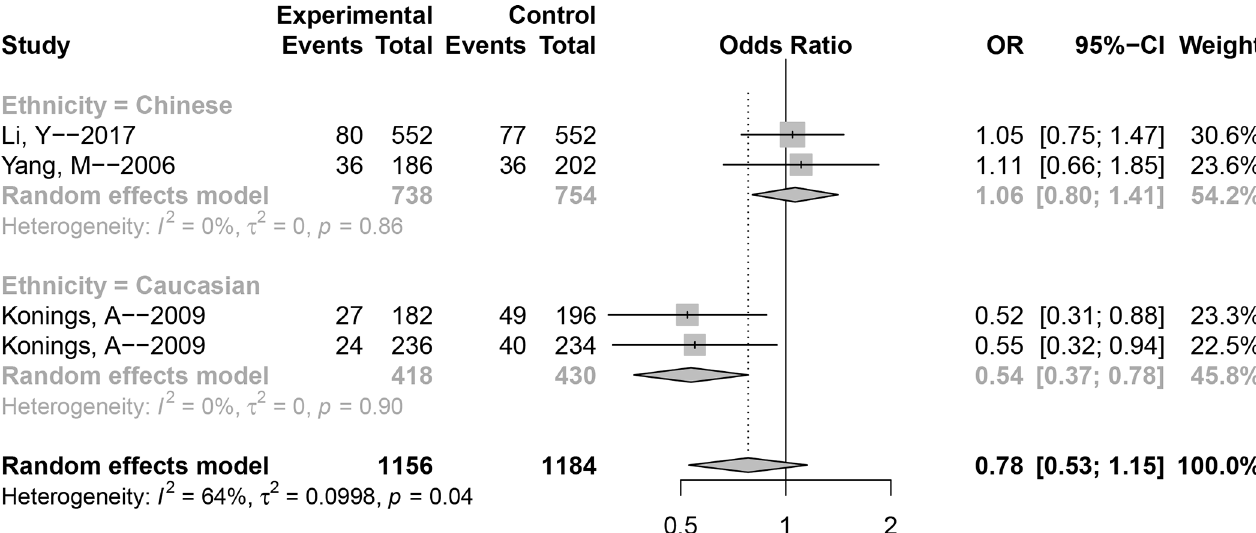
Fig 5. Forest plot of the association between polymorphism rs2227956 and noise-induced hearing loss (NIHL) (Allele model: C versus T).